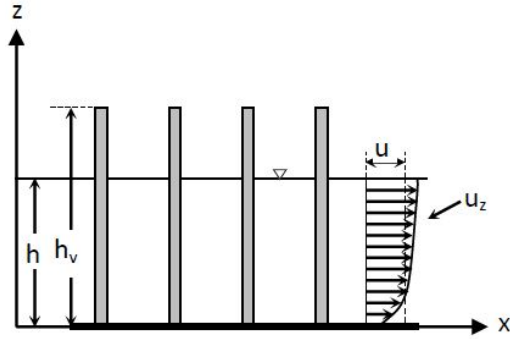
Figure 3. Side view of emergent vegetation and velocity profile.